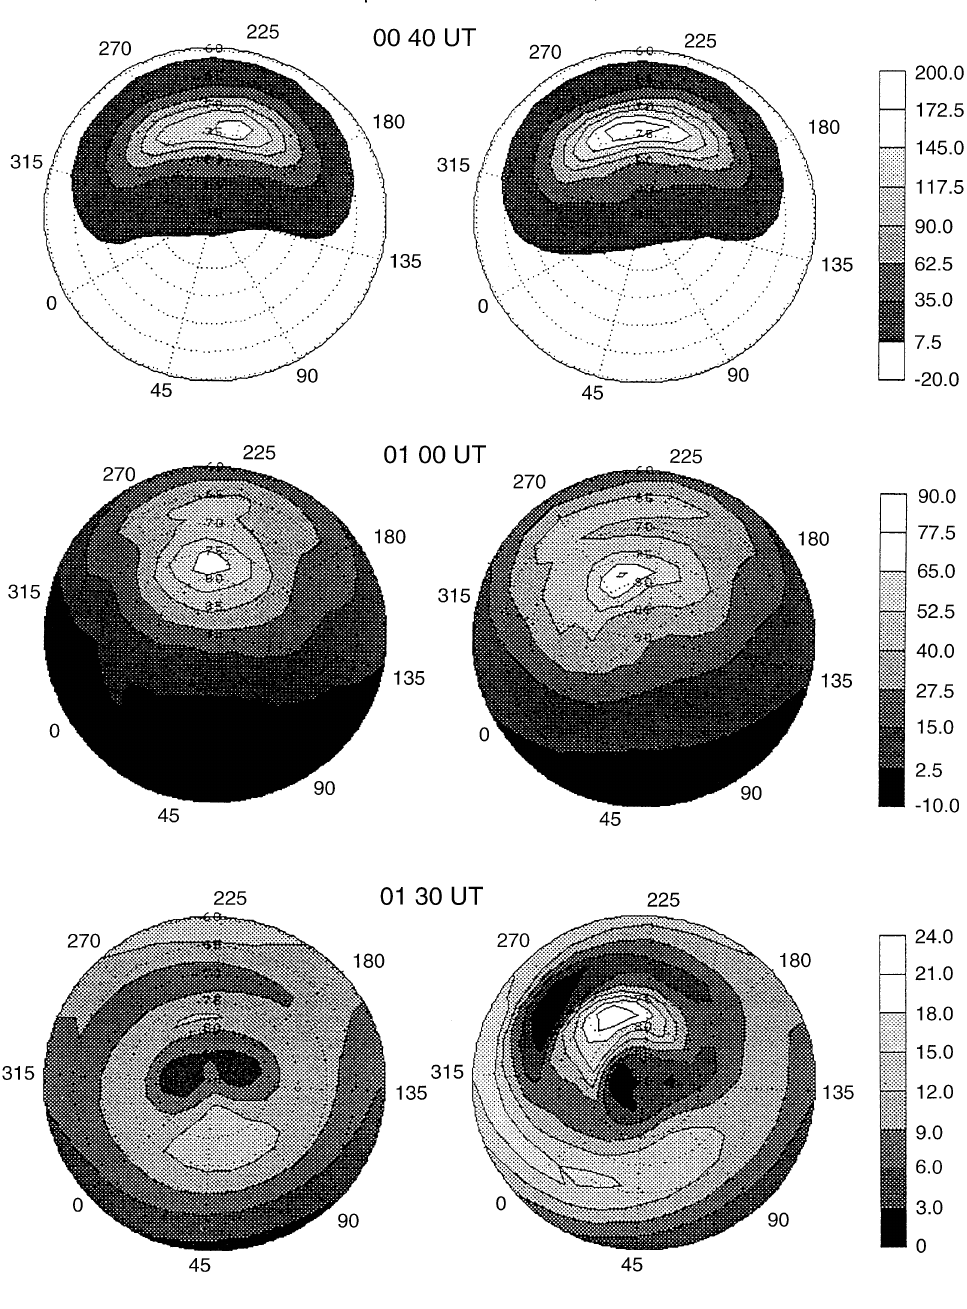
Fig. 8. North geomagnetic polar plots (60 °— 90 ° ) of the calculated neutral-temper- ature disturbance at h " 300 km in variants 2 ( left - hand plots ) and 3 ( right - hand plots ) of the calculations at 0040, 0100 and 0130